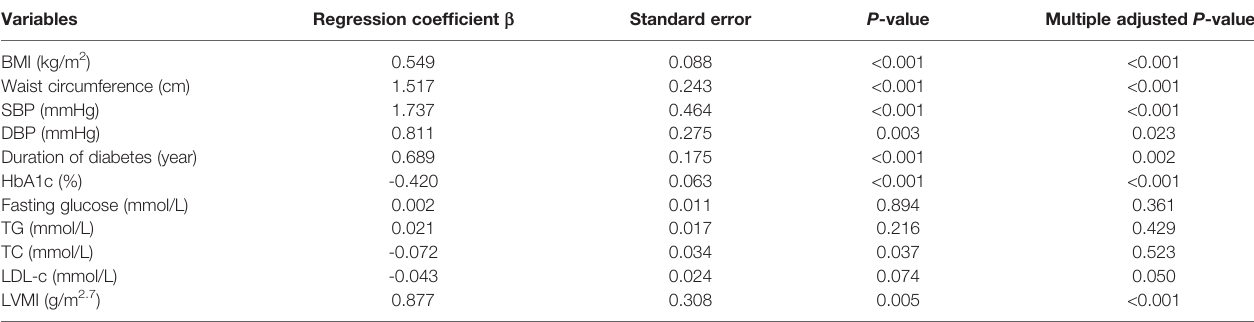
TABLE 3 | Clinical correlation of urinary sodium excretion levels with clinical and biochemical